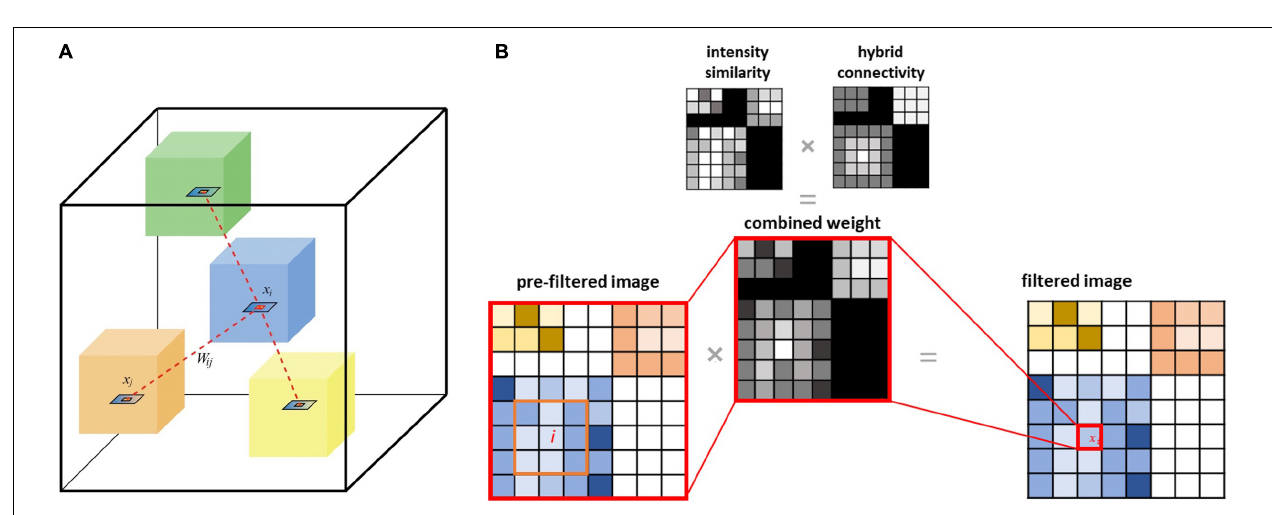
FIGURE 1 | Illustration of proposed hybrid connectivity weighting. Each column from left to right: the noisy images without postfiltering plus structural connectivity information (schematically indicated by the connecting streamlines), the local connectivity, the structural connectivity-derived distant connectivity, and the hybrid connectivity weighting. Top row : a schematic demonstration of the computation of distant connectivity and local connectivity for smoothing voxel i (indicated by a red box). These two matrices are combined to form a hybrid connectivity weighing. Bottom row : a realistic example of smoothing voxel i (indicated by *) in a noisy positron emission tomography (PET) image. λ is set to 0.5 in both examples.